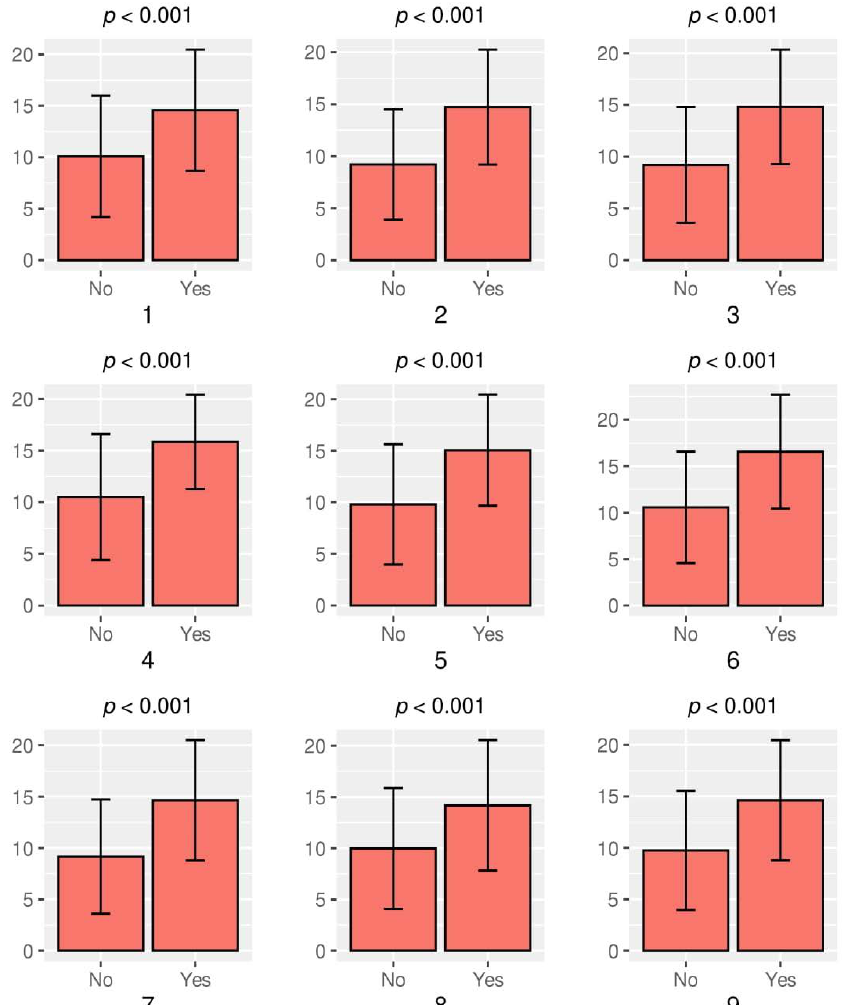
Figure 1. Analysis of the negative affectivity (NA) in relation to the symptoms of SSDs. Legend: 1—TMJ Pain, 2—Headache, 3—Pain in the neck and shoulder girdle, 4—Facial pain, 5—TMJ acoustic symptoms, 6—TMJ blocking, 7—Teeth clenching, 8—Teeth grinding, 9—Increased masticatory muscles tension.